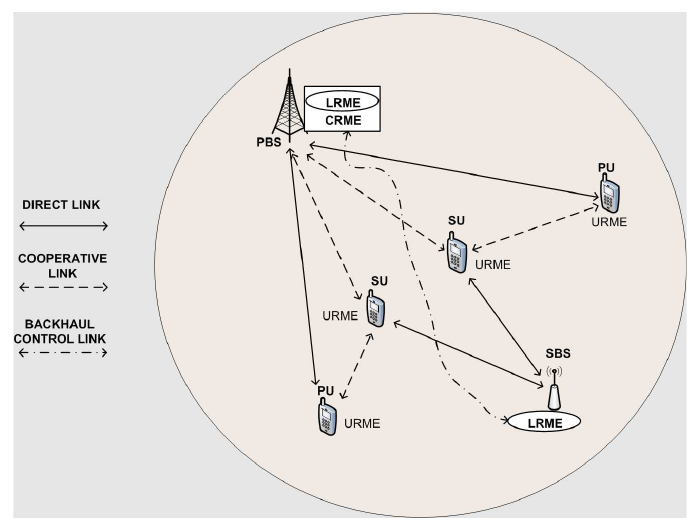
Figure 1. Proposed architecture and scenario for the cell.